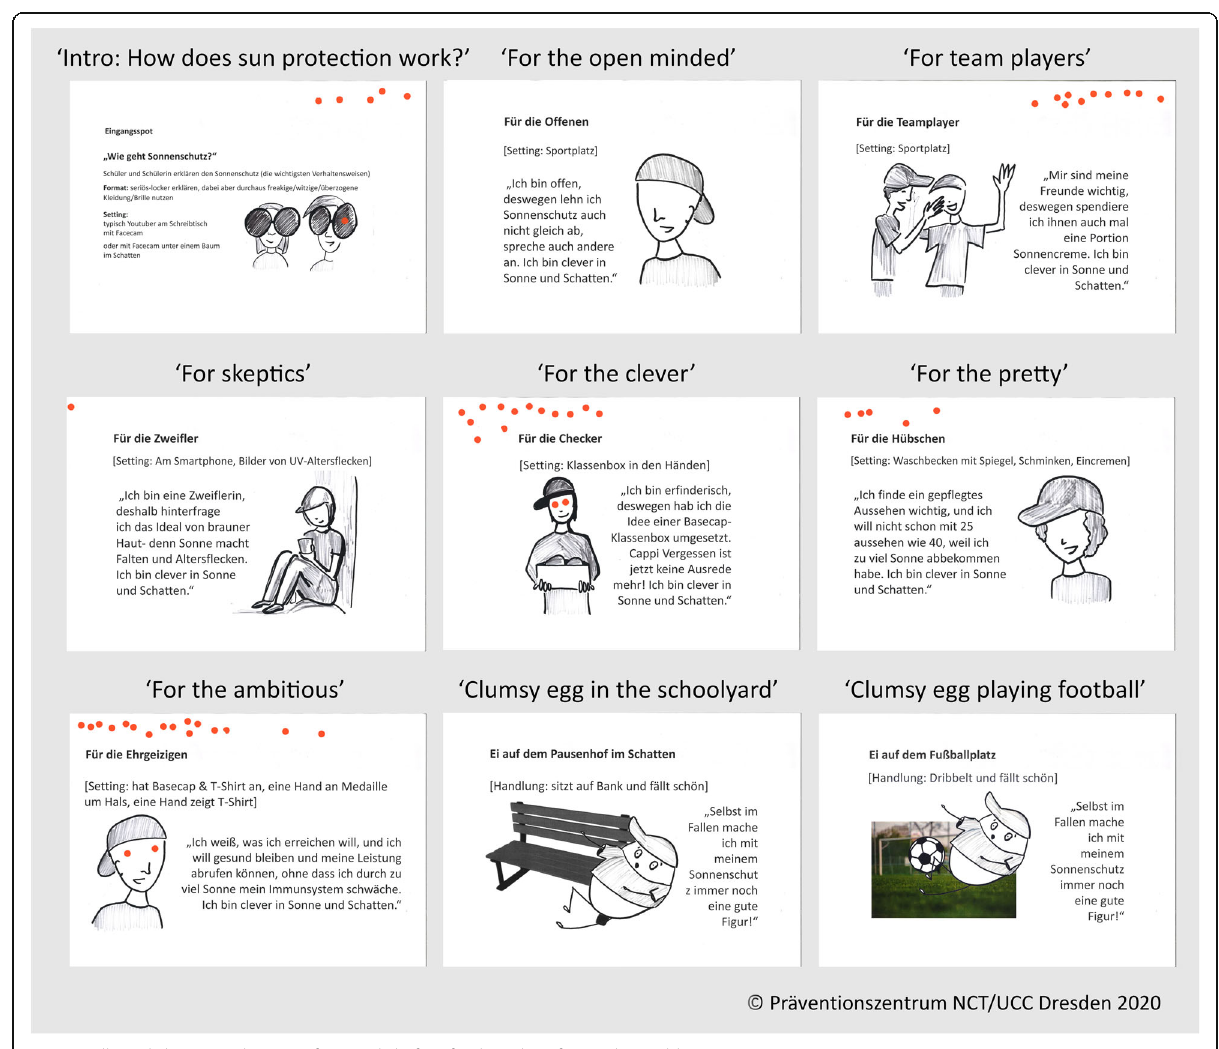
Fig. 2 Adhered dots on selection of printed drafts of video ideas for student athletes